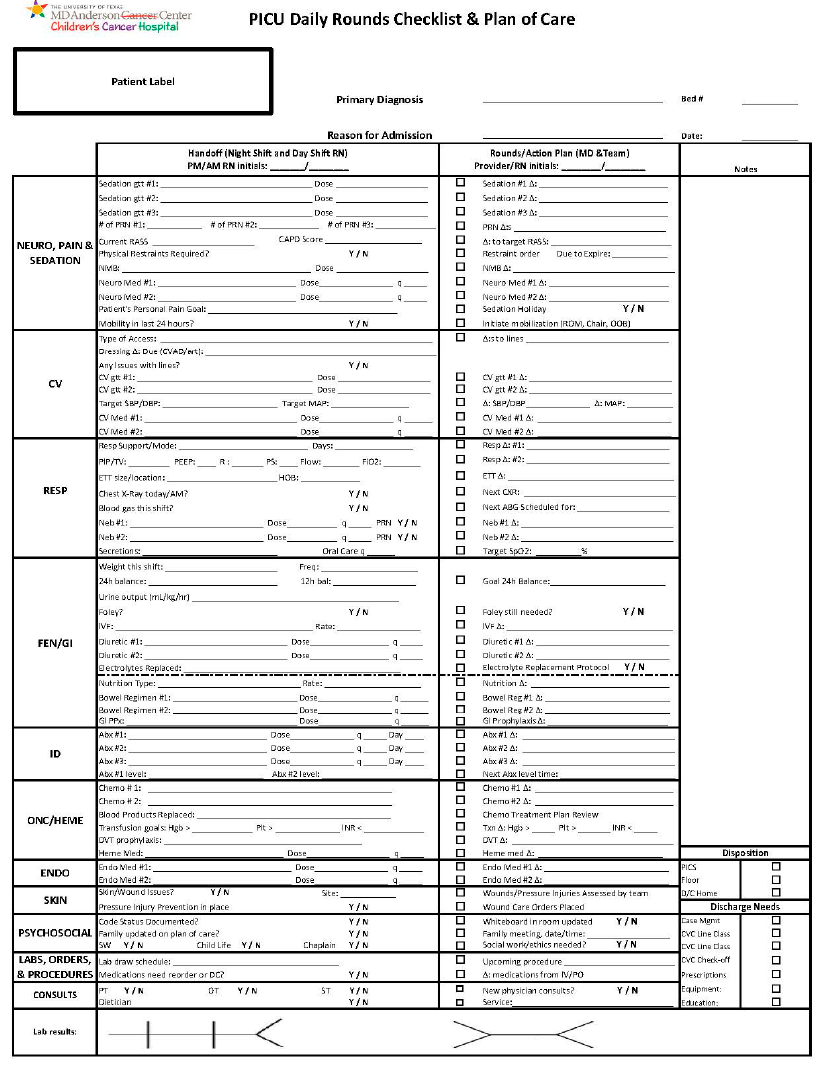
Figure 1. Pediatric Intensive Care Unit Multidisciplinary Rounds (MDR) Checklist. Organ system- based standardized rounding checklist that addressed key elements during MDR. Organ systems listed in first column from left, patient data presented from second column, patient plan of care for shift created in third column, and additional notes annotated in fourth column. PICU = Pedi- atric Intensive Care Unit. NEURO = Neurologic. gtt = Gutta (continuous infusion). PRN = Pro Re Nata (as needed). RASS = Richmond Agitation–Sedation Scale. CAPD = Cornell Assessment for Pediatric Delirium. NMB = Neuromuscular blockade. q = Every. ROM = Range of Motion. OOB = Out of Bed. CV = Cardiovascular. CVAD = Cardiovascular Access Device. SBP = Systolic Blood Pressure. DBP = Diastolic Blood Pressure. MAP = Mean Arterial Pressure. RESP = Res- piratory. PIP = Peak Inspiratory Pressure. TV = Tidal Volume. PEEP = Positive End-Expiratory Pressure. R = Rate. PS = Pressure Support. FiO2 = Fraction of Inspired Oxygen. ETT = Endotra- cheal Tube. HOB = Head of Bed. CXR = Chest X-ray. ABG = Arterial Blood Gas. SpO2 = Sat- uration of Peripheral Oxygen. FEN = Fluids, Electrolytes, and Nutrition. GI = Gastrointestinal. Freq = Frequency. Bal = Balance. IVF = Intravenous Fluids. PPx = Prophylaxis. ID = Infectious Diseases. Abx = Antibiotics. Onc = Oncology. Heme = Hematology. Chemo = Chemotherapy. Hgb = Hemoglobin. Plt = Platelets. INR = International Normalized Ratio. DVT = Deep Venous Thrombosis. Txn = Transfusion. ENDO = Endocrine. SW = Social Work. DC, D/C = Discon- tinue. IV = Intravenous. PO = Per os (oral). PT = Physical Therapy. OT = Occupational Therapy. ST = Speech Therapy. PICS = Pediatric Intensive Care Service. CVC = Central Venous